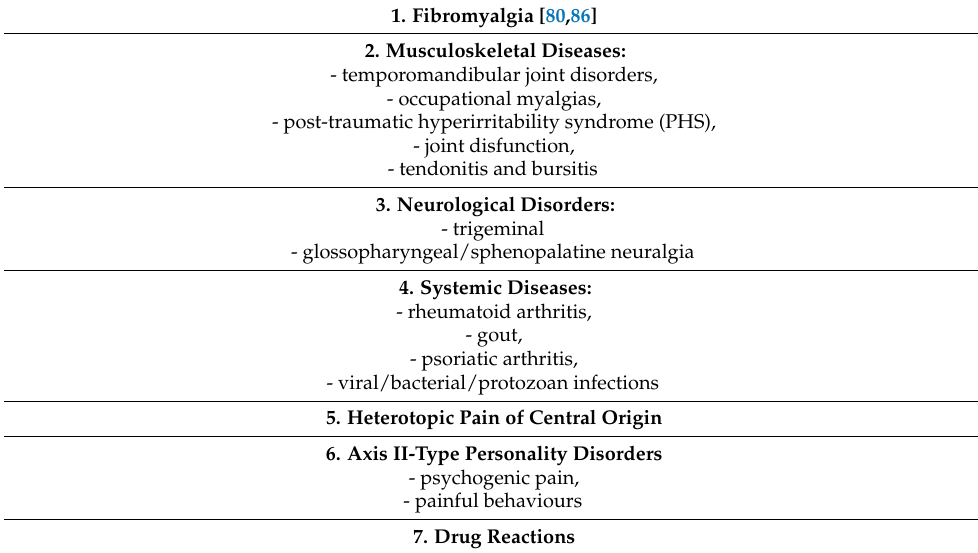
Table 2. Medical disorders considered in the differential diagnosis of MPS as a general